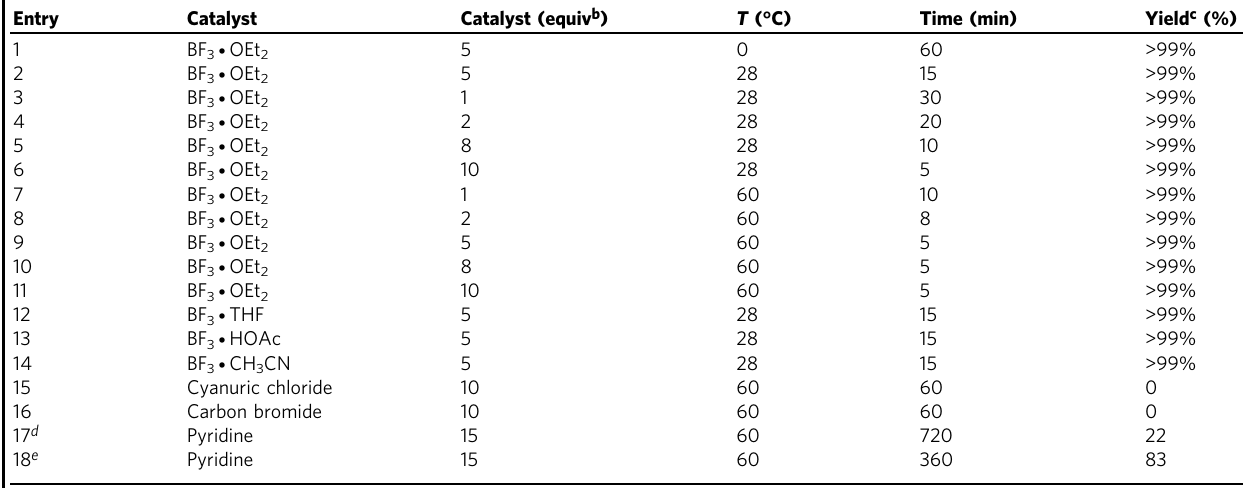
a Reactions were performed using ITIC-CHO and IC with a molar ratio of 1:2. b Relative to IC group. c The yields were determined by 1 H NMR spectroscopy (400MHz) with toluene-d 8 as an internal standard and solution. d CDCl 3 used as solvent, and 2 equiv. IC group was used.